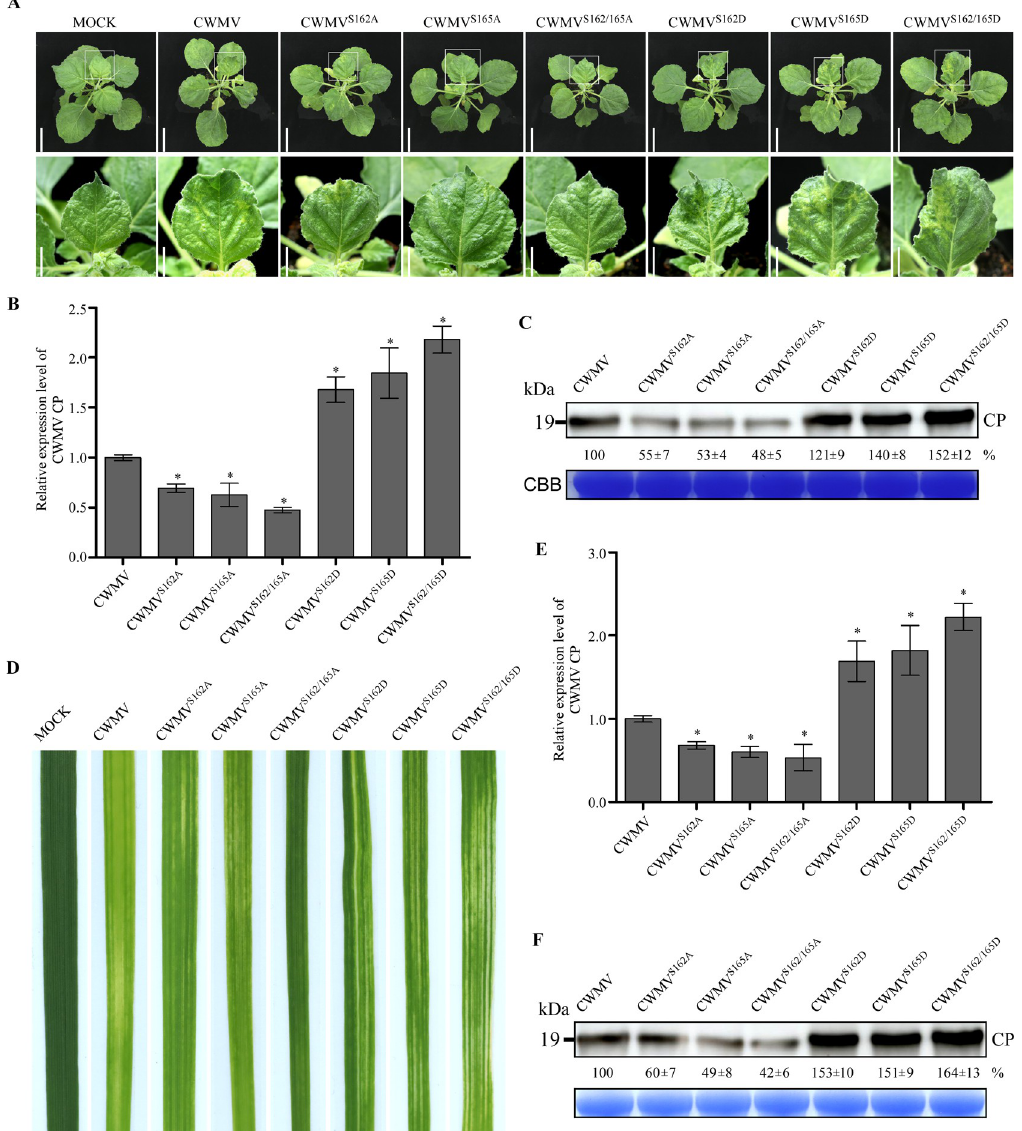
Fig 2. Phosphorylation of CRP at S162 or S165 is crucial for CWMV infection. A. Systemic mosaic symptoms in the CWMV-, CWMV S162A -, CWMV S165A -, CWMV S162/165A -, CWMV S162D -, CWMV S165D - or CWMV S162/165D -infected N . benthamiana plants. Photographs were taken at 21 dpi. Scale bar = 5 cm (upper panel), Scale bar = 2 cm (lower panel). B. Relative expression level of CWMV CP in the assayed N . benthamiana plants, determined through qRT-PCR using CWMV CP gene specific primers. The data presented are the means ± standard deviations (SD), calculated using the Student’s t -test. Each treatment had three biological replicates. � , P < 0.05. C. Accumulation of CWMV CP in the assayed N . benthamiana leaf samples was determined through western blot analysis using a CWMV CP specific antibody. The CBB-stained gel is used to show sample loadings. D. Systemic mosaic symptoms in wheat leaves infected with CWMV, CWMV S162A , CWMV S165A , CWMV S162/165A , CWMV S162D , CWMV S165D or CWMV S162/165D . Photographs were taken at 21 dpi. E. The relative expression level of CWMV CP in the assayed wheat plants was determined through qRT-PCR using CWMV CP gene specific primers. The data presented are the means ± SD, determined using the Student’s t -test. Each treatment had three biological replicates. � , P < 0.05. F. Accumulation of CWMV CP in the assayed wheat plants was determined through western blot analysis using a CWMV CP specific antibody. The CBB-stained gel is used to show sample loadings.